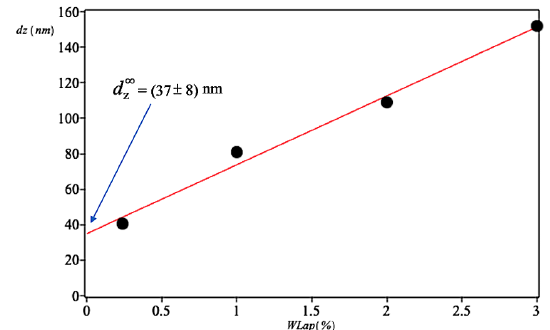
Figure 2. LAP Hydrodynamic diameter in binary mixtures at 25 ◦ C. The extrapolated value at infinite dilution is very close to the diameter of a single LAP disk.